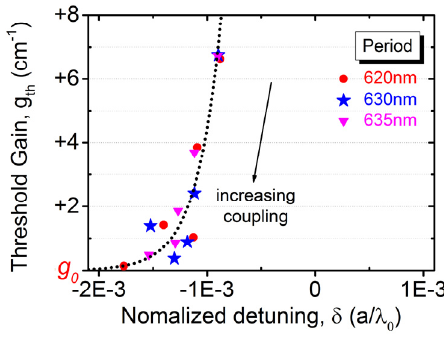
Figure 8. The threshold modal gain is plotted as a function of normalized frequency detuning.